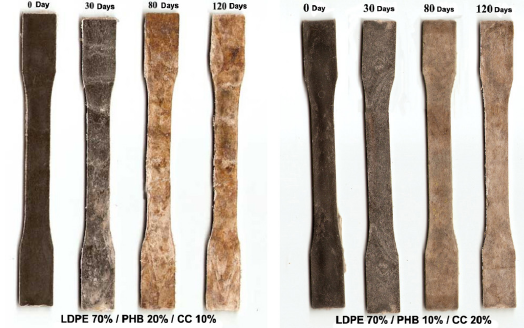
Figure 9. Visual appearance of LDPE/PHB/CC specimens after removal from the soil in different time intervals.